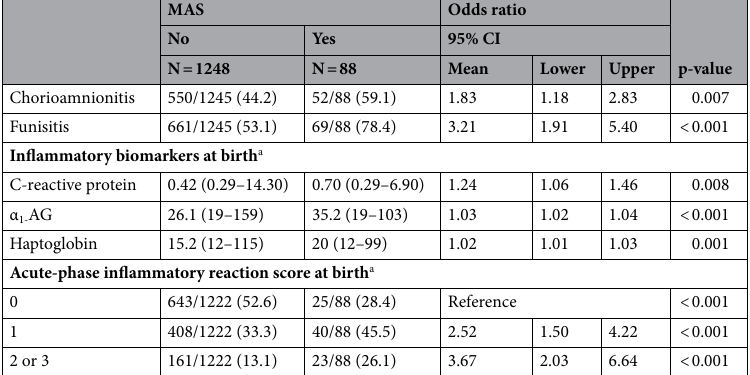
Table 2. Association of the development of meconium aspiration syndrome, histopathological findings, and inflammatory biomarkers among neonates with meconium-stained amniotic fluid on univariate analysis. Values, excluding biomarkers, are expressed as the number (%). Values of biomarkers are presented as the median (range). Acute-phase inflammatory reaction scores of 0–3 were assigned according to the elevation of C-reactive protein, α 1 -acid glycoprotein, and haptoglobin (see Supplemental Information S4). CI confidence interval, α